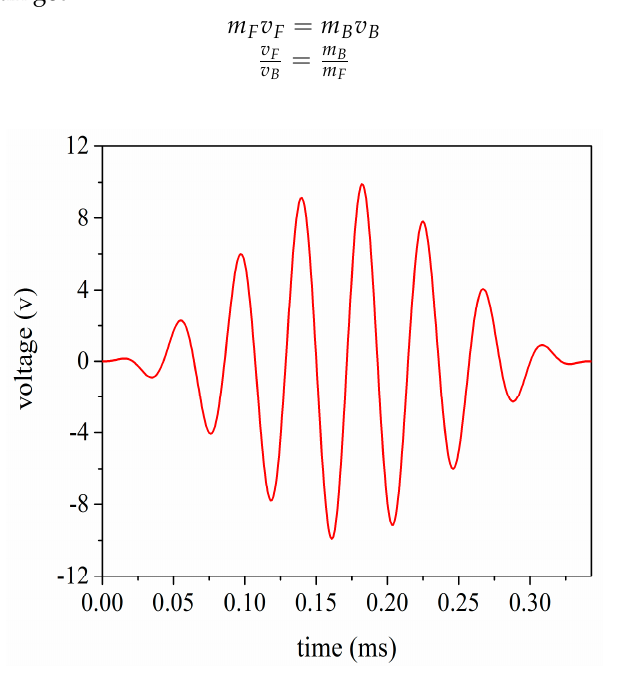
Figure 12. The single tone signal modulated by Hanning window.